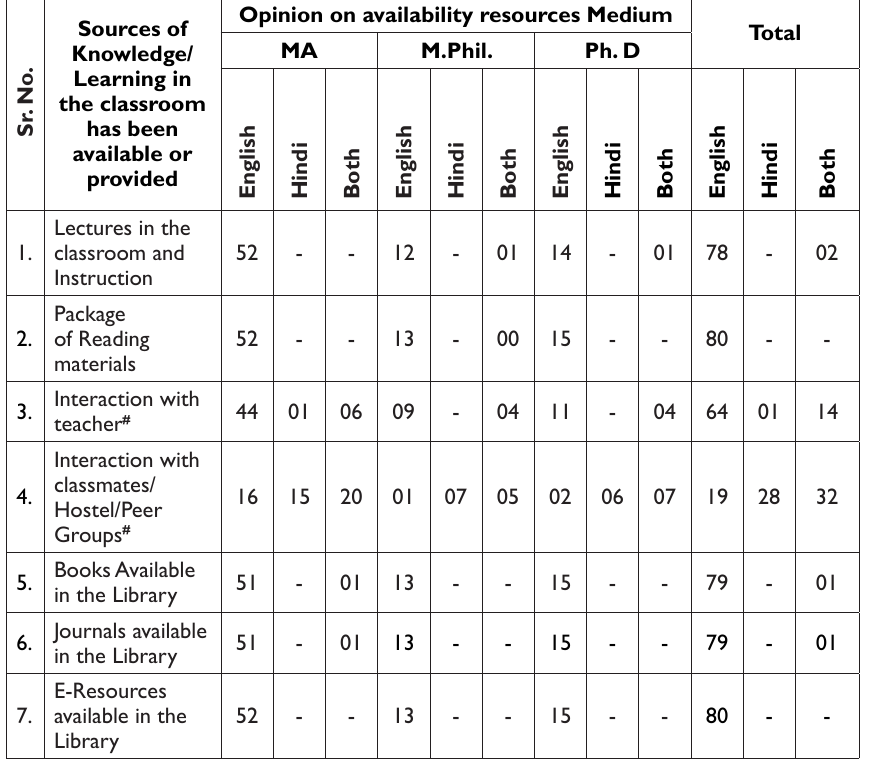
Table 2: Language of reading materials in the classroom and library